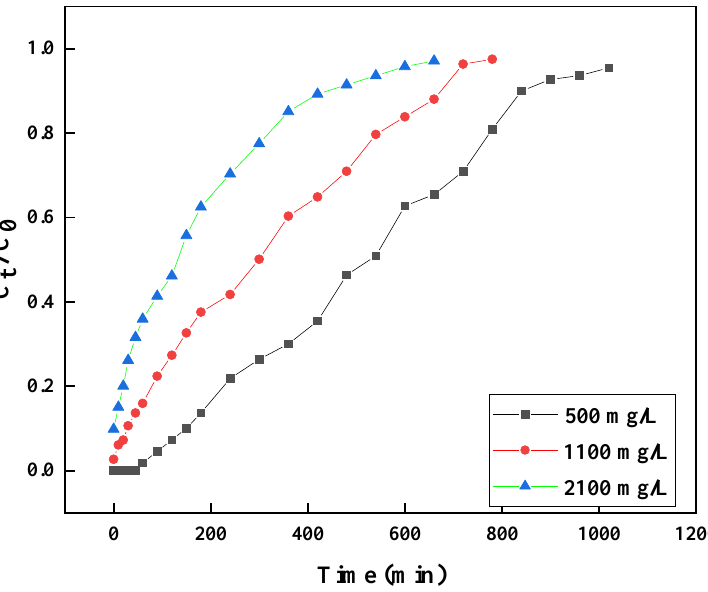
Figure 7. Breakthrough curve for the adsorption of sulfate onto WS60 composite pellet at different initial sulfate concentrations. Bed depth, 40 cm; flow rate, 2 mL/min; pH 5.2 (0.03 M sodium acetate buffer).